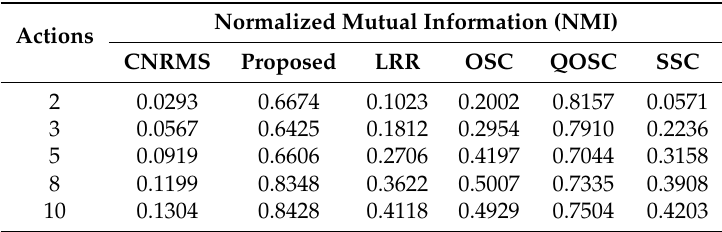
Table 4. 3D action normalized mutual information (NMI) on MSR Action3D dataset.